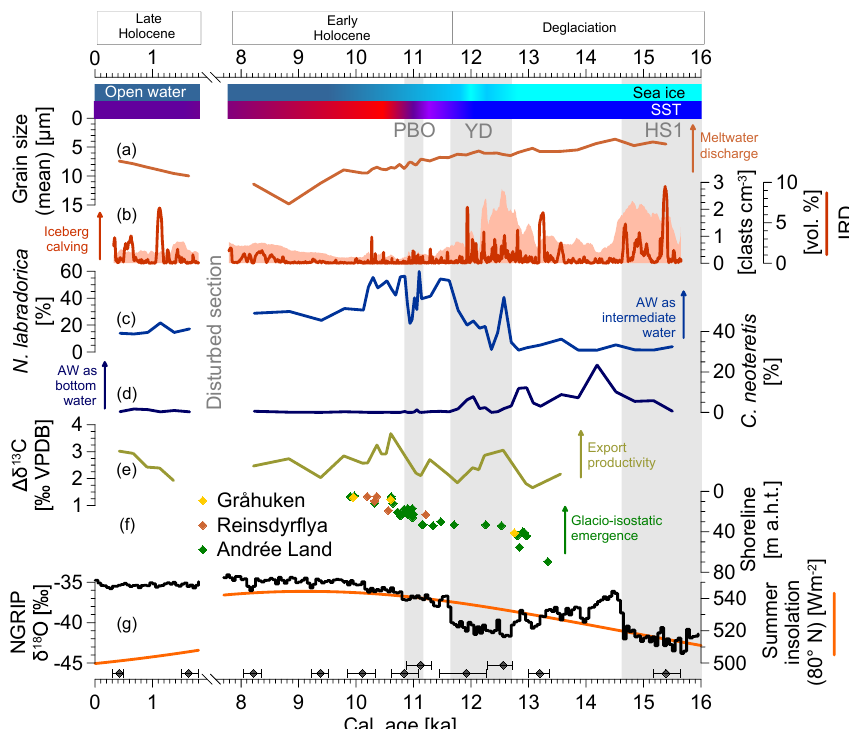
Figure 8. The blueish horizontal bar on top symbolizes sea ice coverage based on biomarker data (PIP 25 index). Red–blue horizontal bar symbolizes (qualitative) sea surface temperatures (red: warm, blue: cold) based on biomarker data (alkenones). (a) Mean grain size of siliciclastic (terrigenous) sediments: low values illustrate deposition of suspended sediment from meltwater plumes (note descending y axis). (b) Volume percentage of ice-rafted debris (solid red line) and number of clasts per cubic centimetre (reddish shading) signifying glacier activity (iceberg calving). (c) Relative percentages of N. labradorica . High percentages: Atlantic Water intrusion into intermediate waters delivering nutrients into the photic zone. Note the almost parallel increase in export production as illustrated in (e) . (d) Relative percentages of C. neoteretis . High percentages: Atlantic Water advection into bottom waters. (e) Offset of epi- and endobenthic δ 13 C values indicating export productivity. (f) Radiocarbon-dated beach ridges in the Woodfjorden area (Forman et al., 2004) illustrating glacio-isostatic emergence (in metres above high tide, ma.h.t.; note descending y axis). Colours mark different locations as indicated in the legend (locations shown in Fig. 1c). (g) Stable oxygen isotopes from NGRIP ice core (black line; S. O. Rasmussen et al., 2014) and June–July insolation at 80 ◦ N